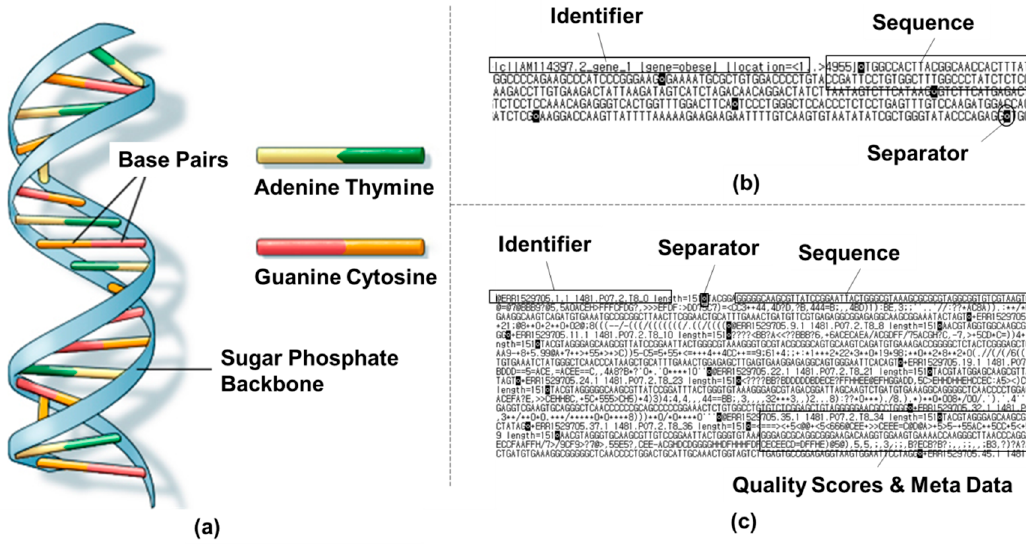
Figure 1. ( a ) DNA Base Pairs Attached to Sugar Phosphate Backbone and DNA Data File Formats of ( b ) FASTA and ( c ) FASTQ.